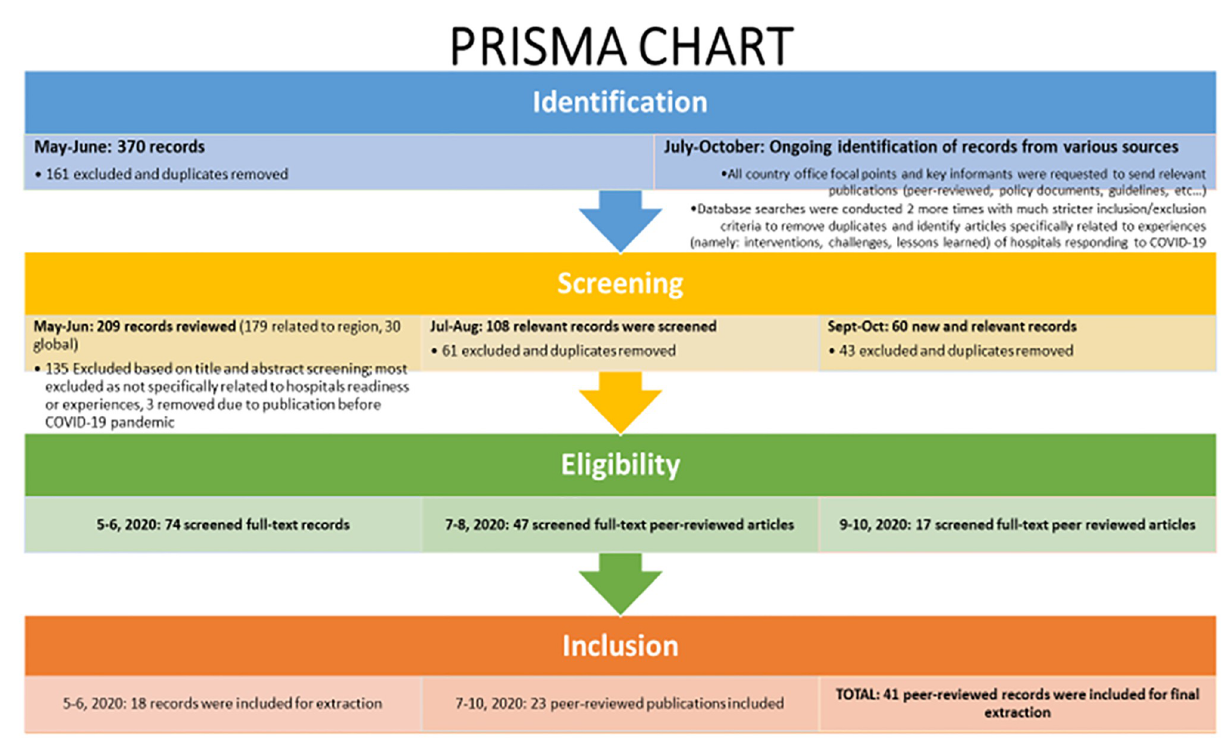
Fig 2. PRISMA chart for literature review and articles